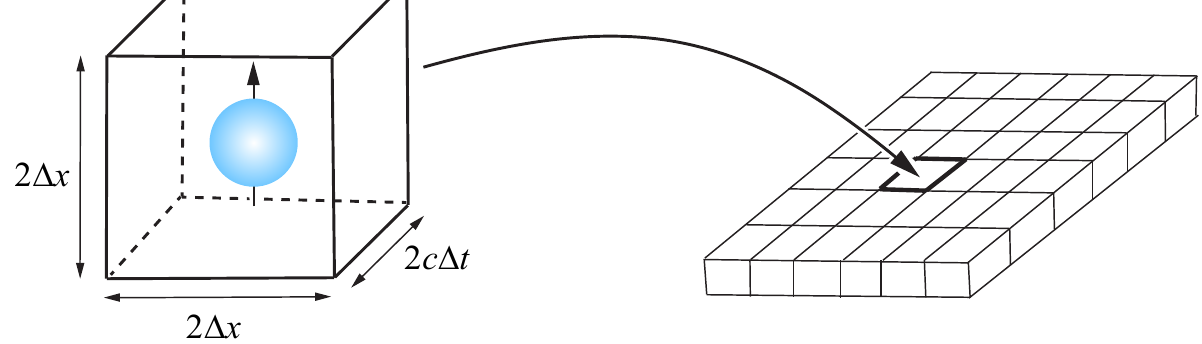
Figure 2: One qubit degree of freedom (represented as a Bloch sphere), e.g. a spin, embedded in a 3d voxel at some minimal scale ∆ x, ∆ t. Here c is the maximal speed of (classical) information transfer. The boundary B can be considered to be a manifold tessellated into such